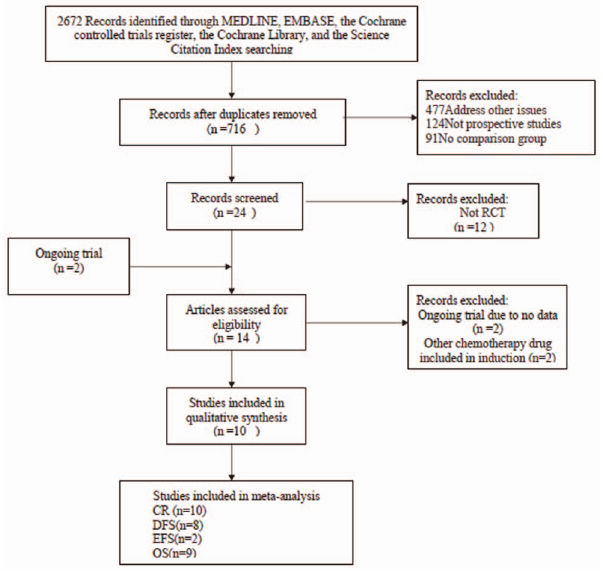
Figure 1. Process of identifying and selecting the relevant randomised controlled trials according to the PRISMA state- ment.